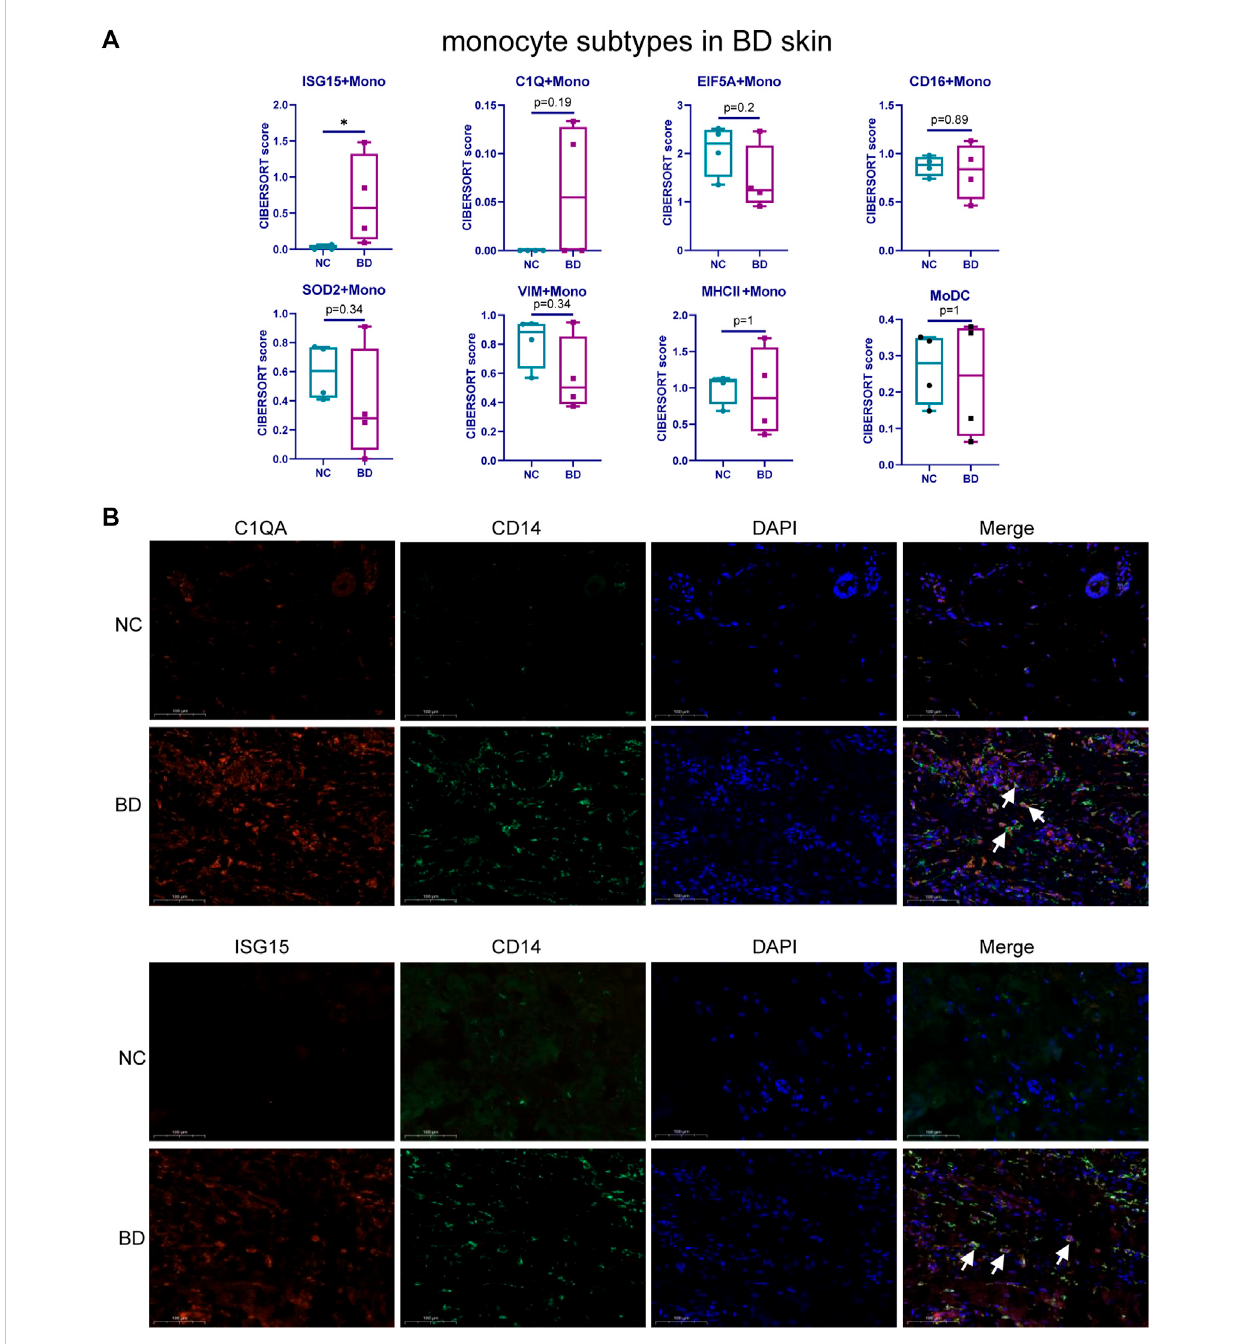
FIGURE 4 HeterogeneityofmonocytesubtypesinBDpatients. (A) BoxplotcomparingtherelativeproportionofmonocytesubsetsinskintissueofBDpatients and NCs analyzed by CIBERSORTx. The Wilcoxon testwas applied. (B) IF staining of CD14+C1QA+ and CD14+ISG15+ in the skin of BD patients and NCs. Representative images show CD14+C1QA+ and CD14+ISG15 + positive cells in the skin of BD patients and NCs. CD14 (green), C1QA (red), ISG15